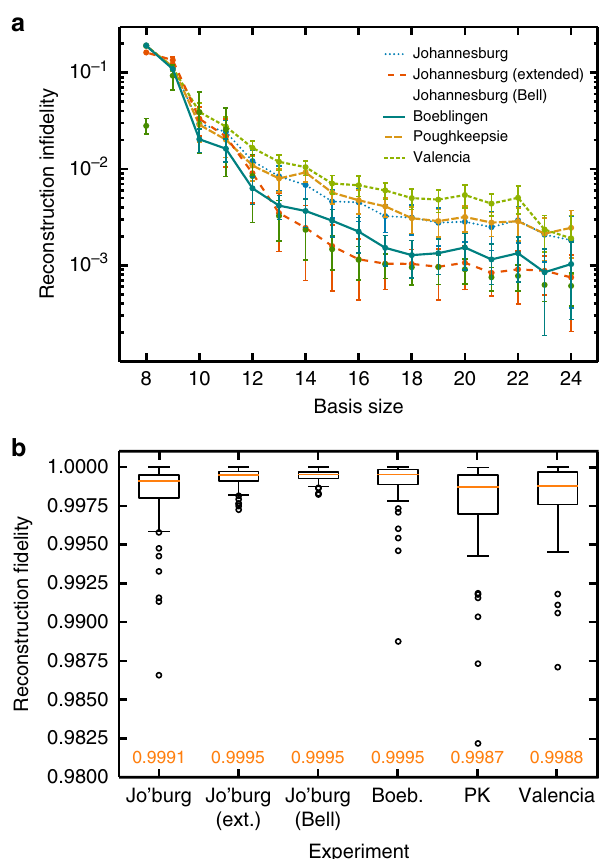
Fig. 2 Reconstruction fi delity. For each basis size, we compare the process tensor predictions with experimentally reconstructed density matrices for predictions that lay outside the basis set. a The average in fi delity in reconstruction between the states predicted by the process tensor and the experimentally measured state. This includes a 95% con fi dence interval, computed using the bootstrapping method described in ref. 41 . The experiments compare the predictions of a basis n process tensor with the experimental outcomes of the 4 × (28 − n ) × (28 − n ) experiments from outside the basis set. In the notation of the ‘ Process characterisation ’ subsection, our basis is P (cid:3) U ð n Þ (cid:3) U ð n Þ . b The distribution of fi delities of the predictions made by a basis-24 process tensor over a range of experiments. The top and bottom of the boxes are, respectively, the 25th and 75th percentiles, the whiskers are 1.5 times the inter-quartile range, and the orange lines are the medians of the distribution, with this last fi gure also provided in orange to four decimal